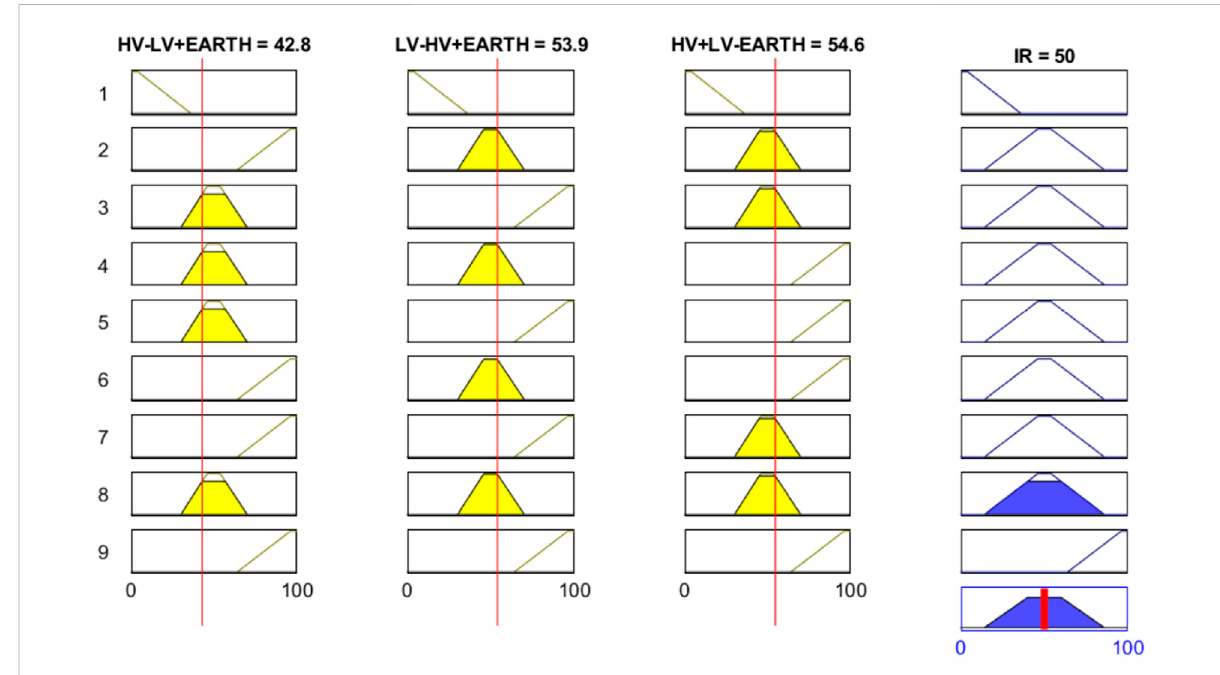
FIGURE 12 Rules used in fuzzy sublogic for insulation resistance and polarization index.